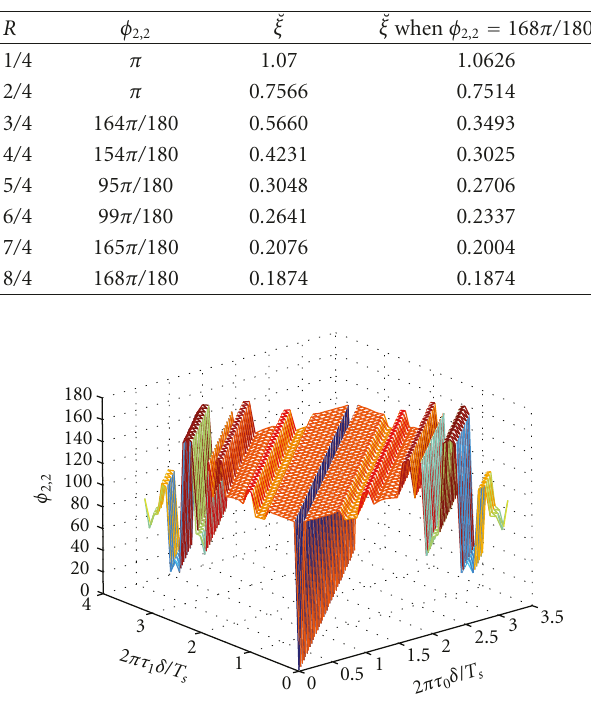
Table 3: Transmission rate R versus optimal rotation angle φ 2,2 and corresponding coding gain lowerbound ˘ ξ for the Multirate MRP in a MIMO-OFDM subsystem with P = 4, N t = Γ = 2, and QPSK for COST 207 Typical urban six-ray power delay profile.